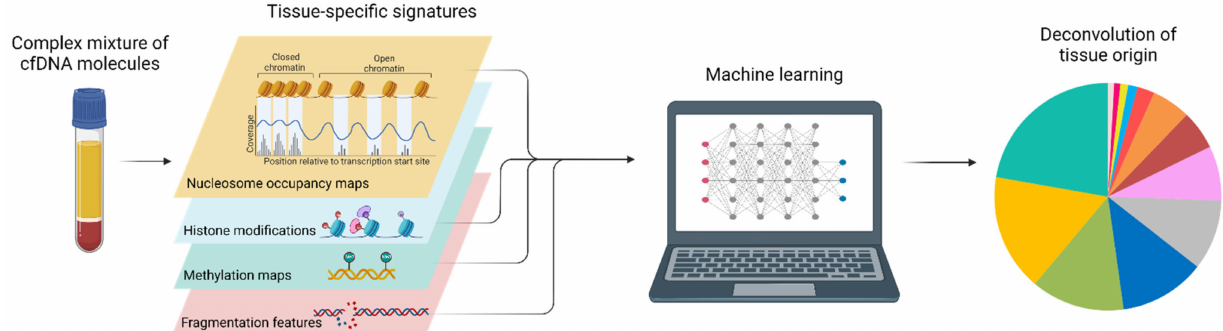
Figure 5. Determining the tissue-of-origin of cfDNA molecules. The cfDNA population in a typical biospecimen is highly complex and derives from numerous different cell and tissue types. However, cfDNA molecules contain multiple layers of cell-type specific epigenetic signatures, such as differ- entially methylated DNA regions, post-translational histone modifications, nucleosome occupancy, as well as various fragmentation features. Through the use of increasingly sophisticated molecular analysis methods coupled with machine learning algorithms, the epigenetic information carried by cfDNA molecules can be decoded to determine the contribution of different tissue